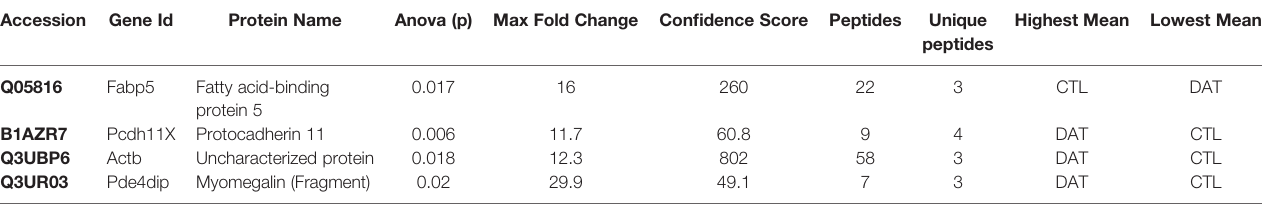
TABLE 3 | Properties of the identi fi ed allergenic proteins following direct antibody treatment (DAT) of the neuroblastoma cell line. Accession Gene